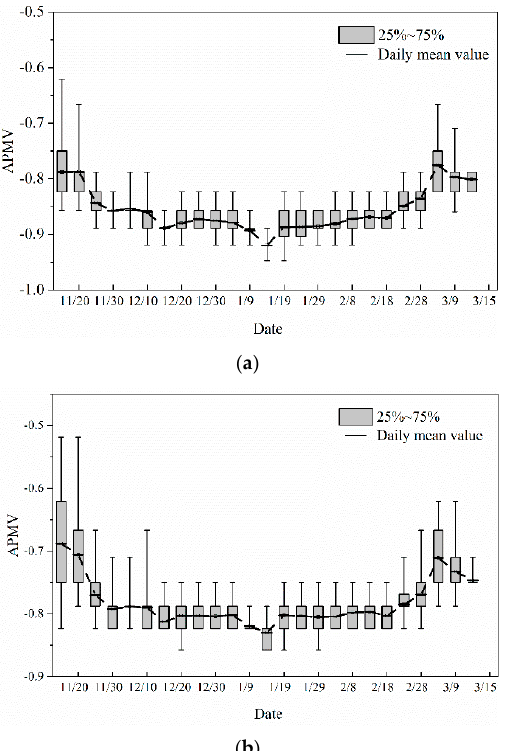
Figure 2. PMV in the living room during heating season: ( a ) original building and ( b ) standard building.